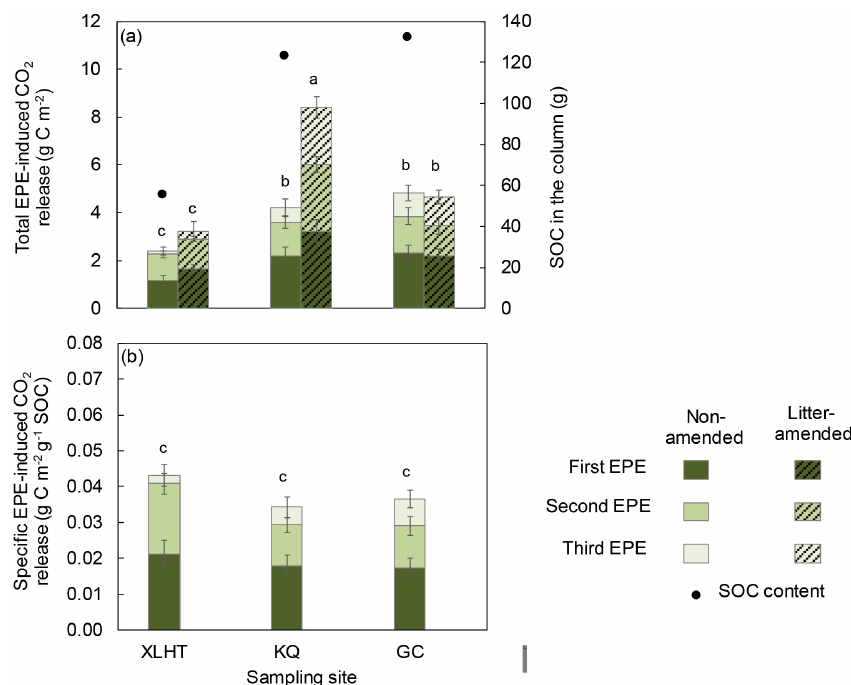
Figure 3. Total (a) and specific (b) EPE-induced CO 2 release in the litter-amended and non-amended grassland soils during three EPEs. Mean values are shown with standard deviation ( n = 3). Lowercase letters (a, b, c) indicate significantly different levels among the litter-amended and non-amended soils determined by Duncan’s multiple range test (one-way ANOVA, p <0.05).